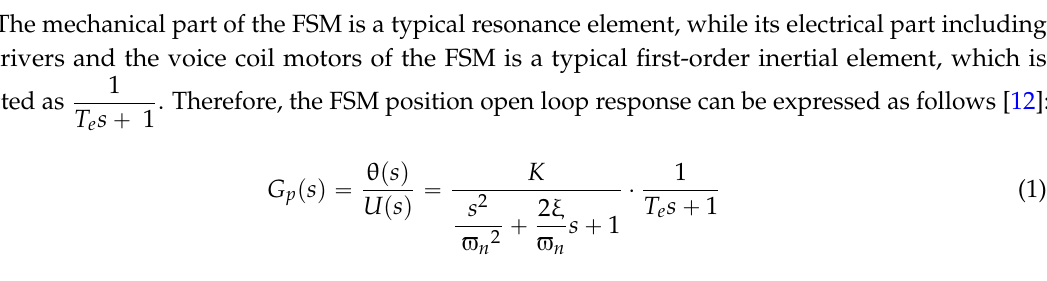
Figure 1. Configuration of the FSM control system.